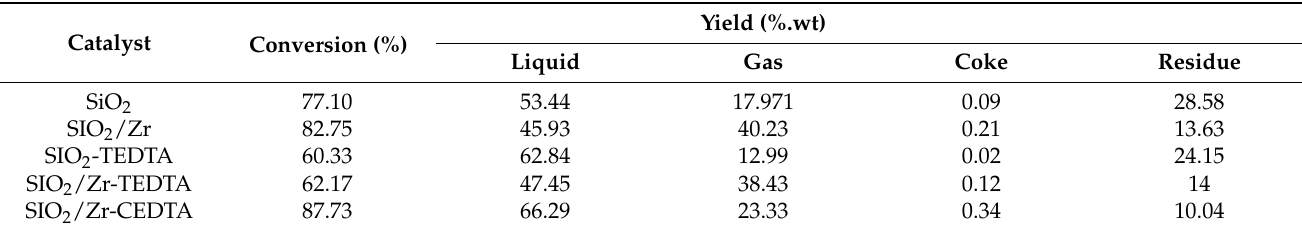
Table 4. Conversion and product yield from CPO hydrocracking with various